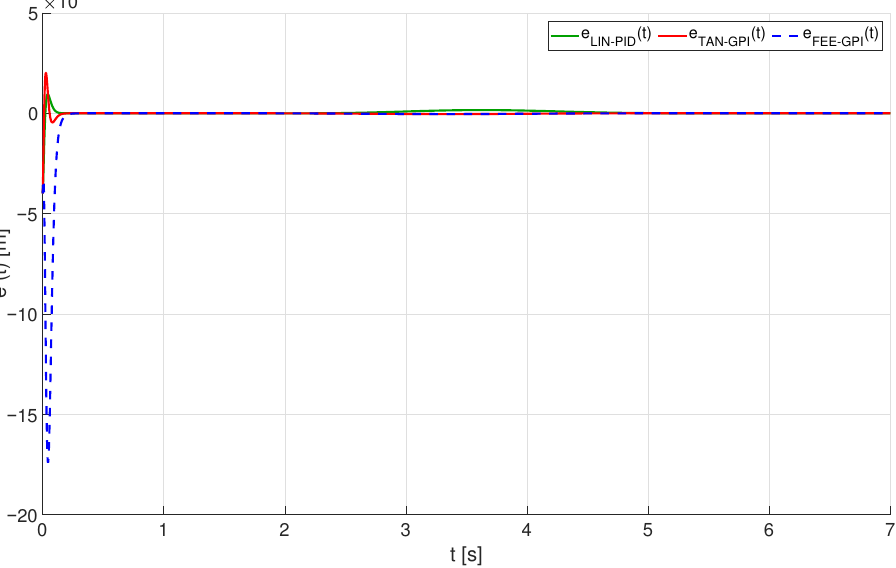
Figure 4. Evolution of tracking error trajectory of the magnetic ball, e ( t ) = y ( t ) − y ∗ ( t )[ m ] , nominal case (Test